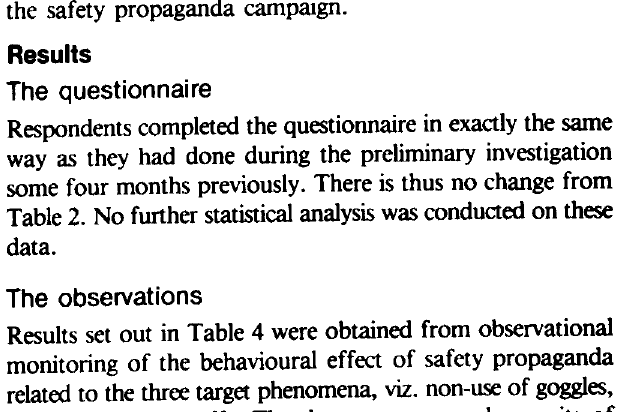
These posters were then printed and used as experimental safety propaganda material in the workshops under investiga tion. Care was taken to position the experimental posters in prorninant positions at the workstations to be monitored. No other safety instruction or advice was given to either managers, supervisors, or